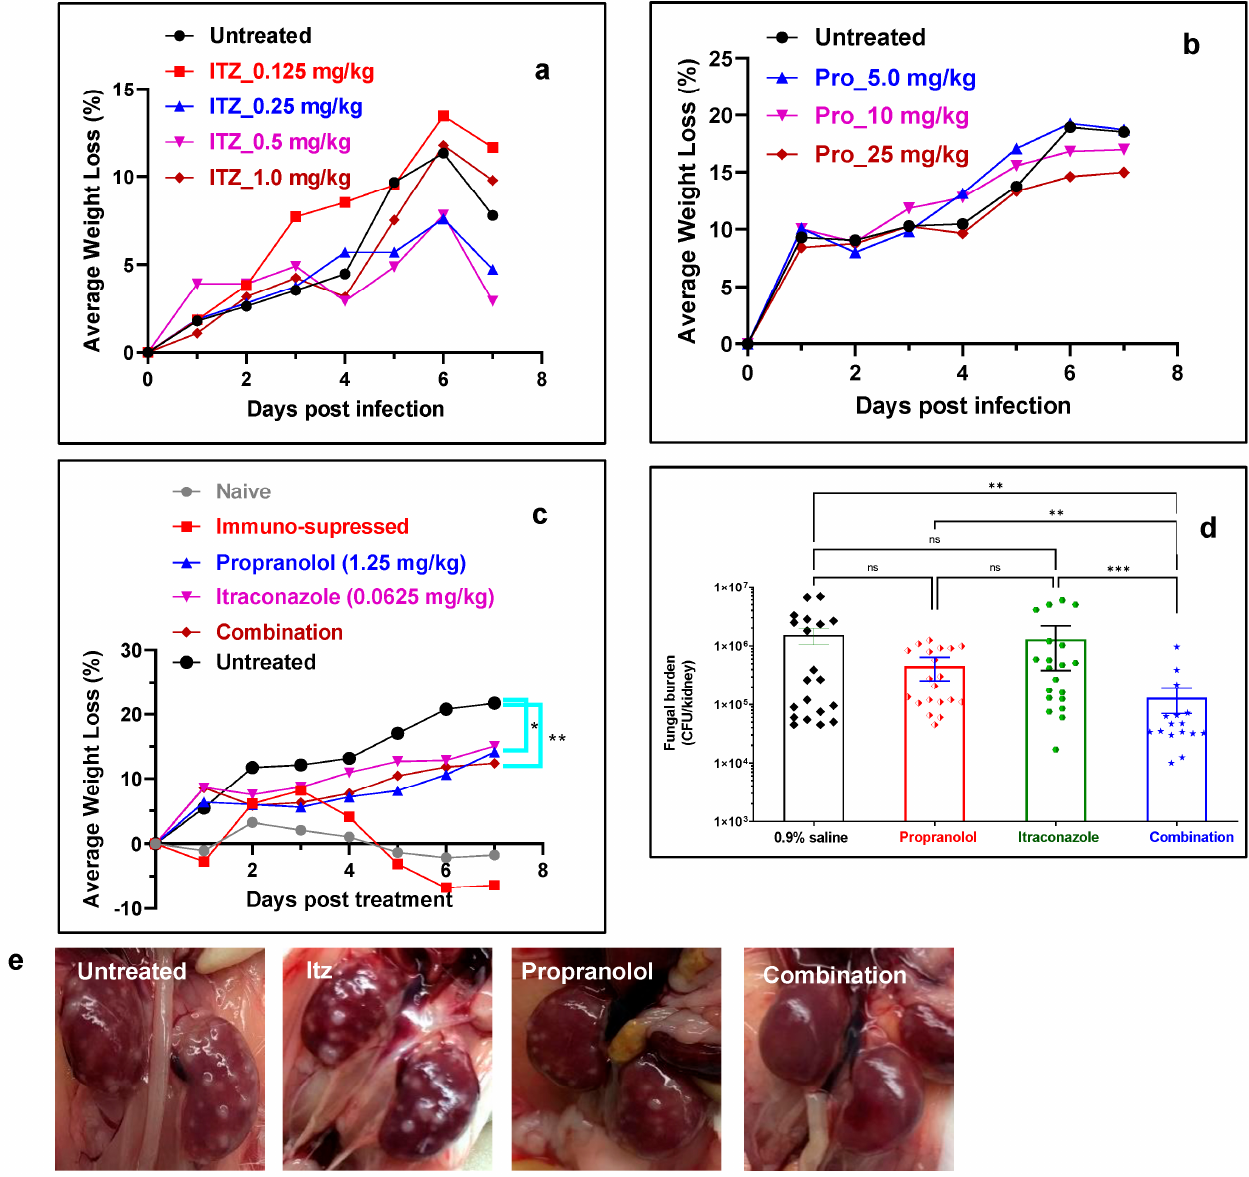
Figure 5. Efficacy of antifungal mono and combination therapies. ( a ) Average body weight loss (%) of infected mice after treatment with Itz monotherapy (n = 4 mice per group). ( b ) Average body weight loss (%) of infected mice after treatment with propranolol monotherapy (n = 4 mice per group). ( c ) Average body weight loss (%) of infected mice after treatment with Itz–propranolol combination monotherapy (n = 10 mice per group). ( d ) Fungal burden in kidneys after treatment with various groups (n = 20 kidneys per group). The error bar indicates mean ± SE.* p ≤ 0.05, ** p ≤ 0.01 and *** p ≤ 0.001 by Kruskal–Wallis multiple comparison test. ( e ) Photographs of kidneys after treatment with various groups.